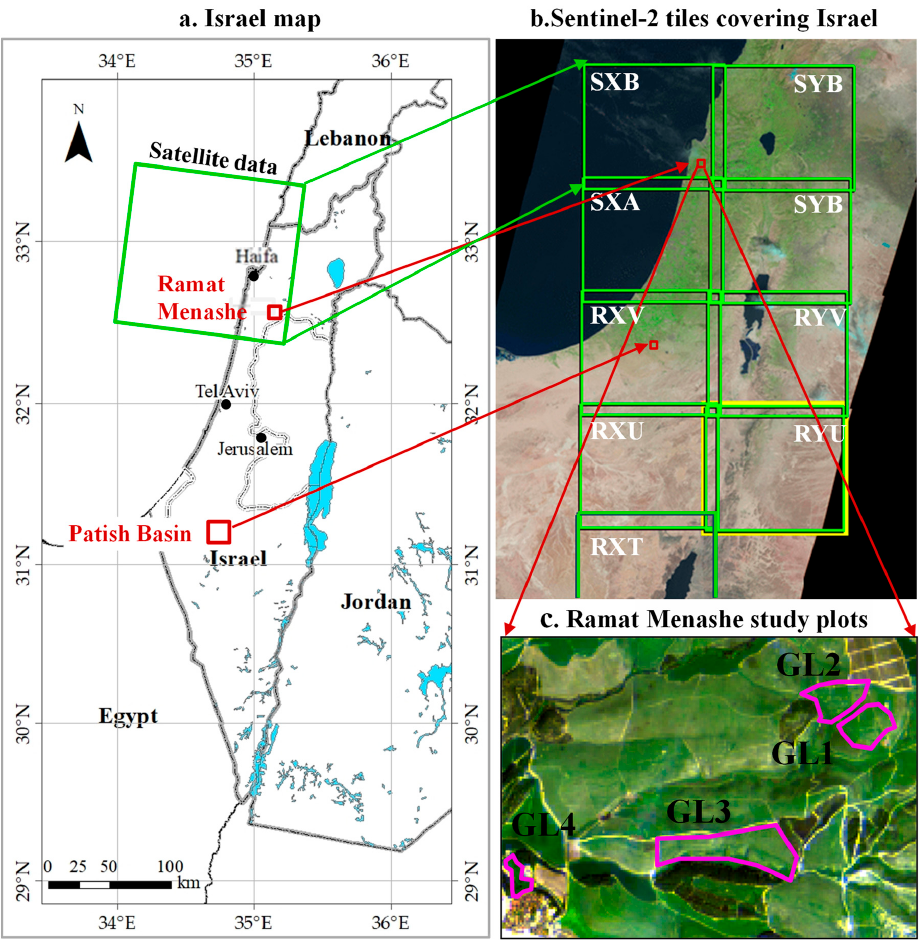
Figure 2. ( a ) Map of Israel. ( b ) Sentinel-2 tiles covering Israel, with the study areas Ramat Menashe and Patish Basin indicated with red rectangles. The northern site was used to collect field measurements for model validation, and the southern site was used to collect vegetation samples for laboratory analysis for the purposes to developing models. ( c ) The four study plots at Ramat Menashe (borders in magenta) shown on a Sentinel-2 image.